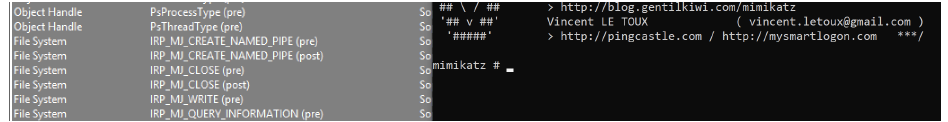
Figure 37. Running mimikatz without interruption.